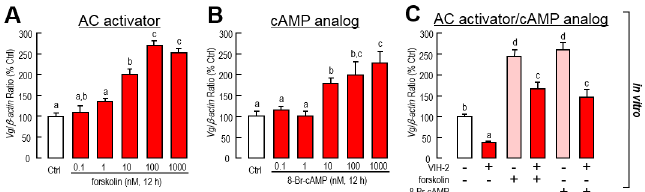
Fig 4. Involvement of cAMP-dependent signaling in VIH-2 suppressed Vg mRNA expression in the hepatopancreas of L . vannamei . A & B: The effects of the AC activator (A) and the cAMP analog (B) on Vg mRNA expressions in shrimp hepatopancreatic cell cultures. The hepatopancreatic cells were incubated for 12 h with increasing doses of forskolin (0.01–1000 nM) or 8-Br-cAMP (0.1–1000 nM). C: Interaction of cAMP-dependent signal pathways and VIH-2 on Vg mRNA expression in shrimp hepatopancreatic cell cultures. The hepatopancreatic cells were incubated for 12 h with VIH-2 (1 μM) in the presence or absence of forskolin (1 μM) or 8-Br-cAMP (1 μM). In this study, the data presented are expressed as the mean±S.E. (n = 4). Experimental groups denoted by the same letter represent a similar level ( P > 0.05, ANOVA followed by Fisher’s LSD test).